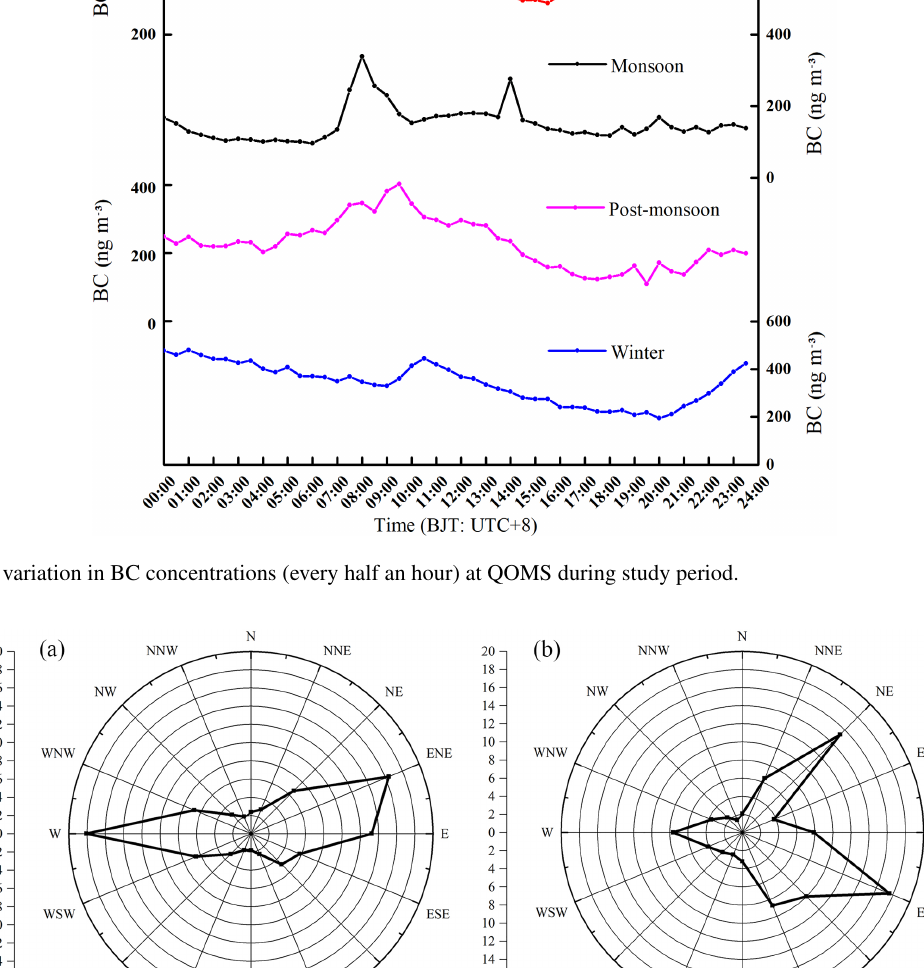
night (12:00–24:00 BJT) (Fig. 5b), accounting for 17.6